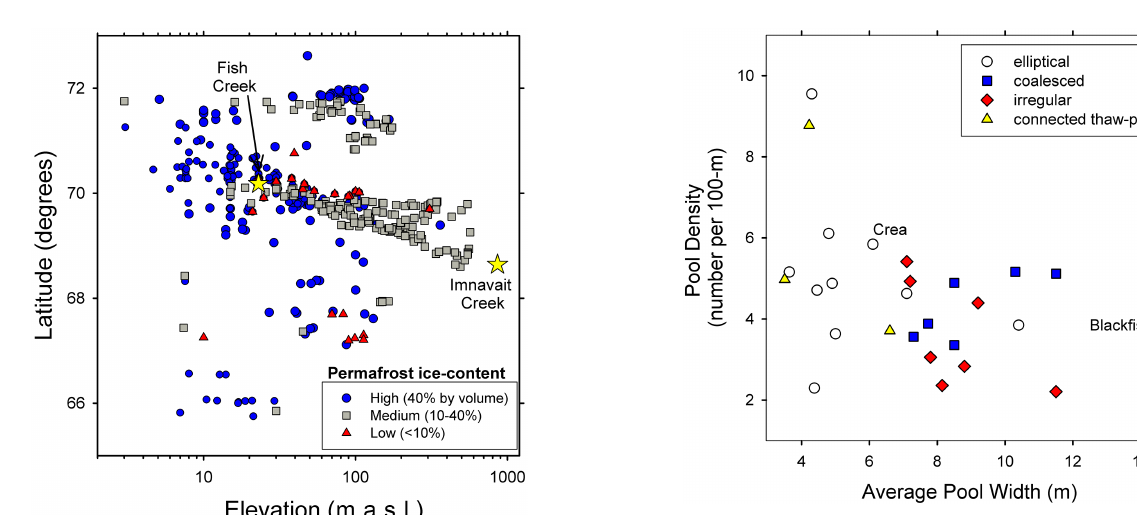
Figure 6. Morphological characteristics of beaded streams com- pared according to pool (bead) density, size, and shape classes (ex- amples shown in Fig. 4 and locations shown in Fig. 3) at the segment scale (1–3km channel length) in the Fish Creek